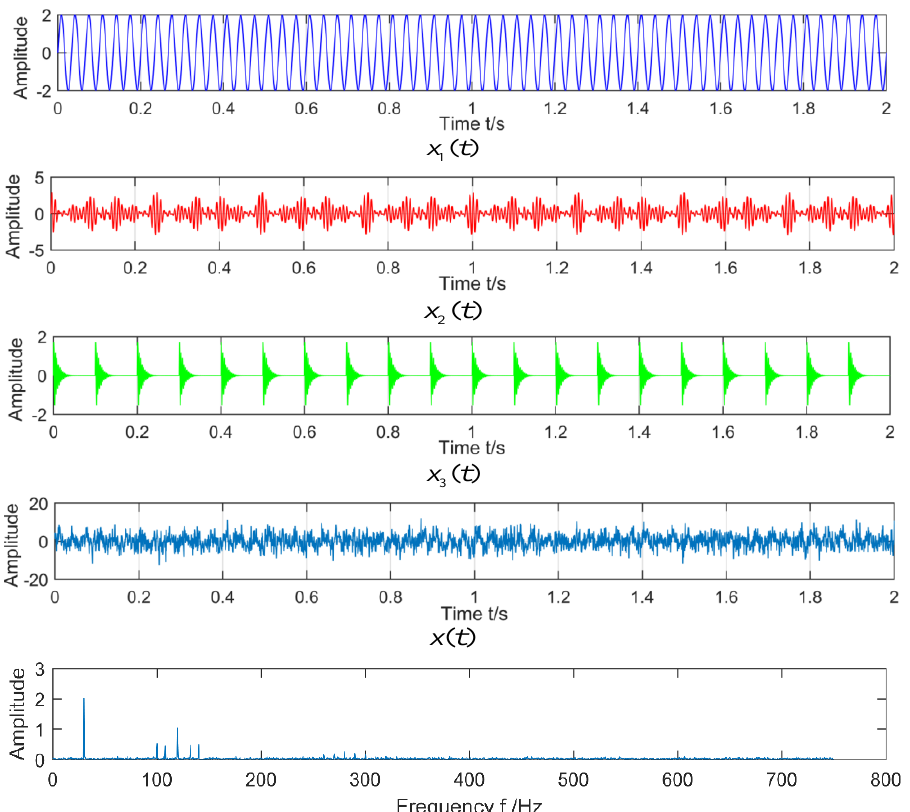
Figure 3. The time domain waveform of each component signal and its spectrum.